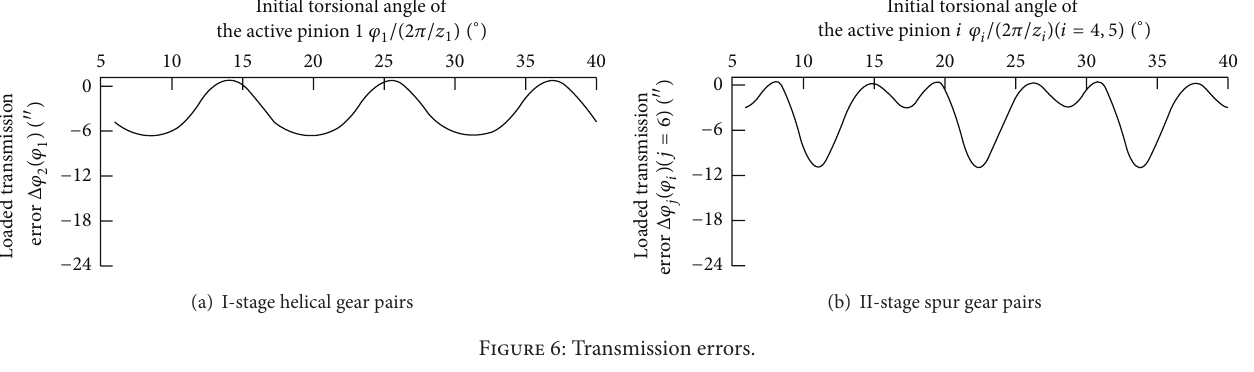
Figure 6: Transmission errors.